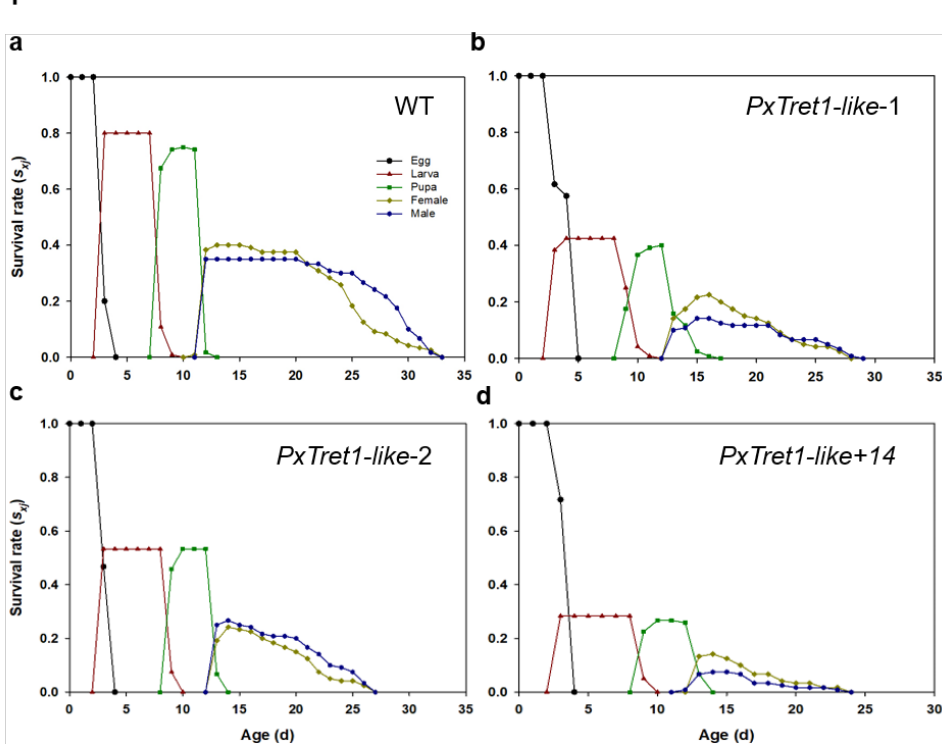
Figure 7. Effects of PxTret1-like knockout on age-stage characteristics of Plutella xylostella . ( i ) Age- stage survival rates ( S xj ) of Plutella xylostella in different strains and in different generations; ( ii ) age- specific survival rates ( l x ), female age-stage specific fecundity ( f x j ) and age-specific fecundity of total population ( m x ) of Plutella xylostella in different strains and in different generations. ( a ): wild-type strain; ( b – d ): mutant of PxTret1-like .